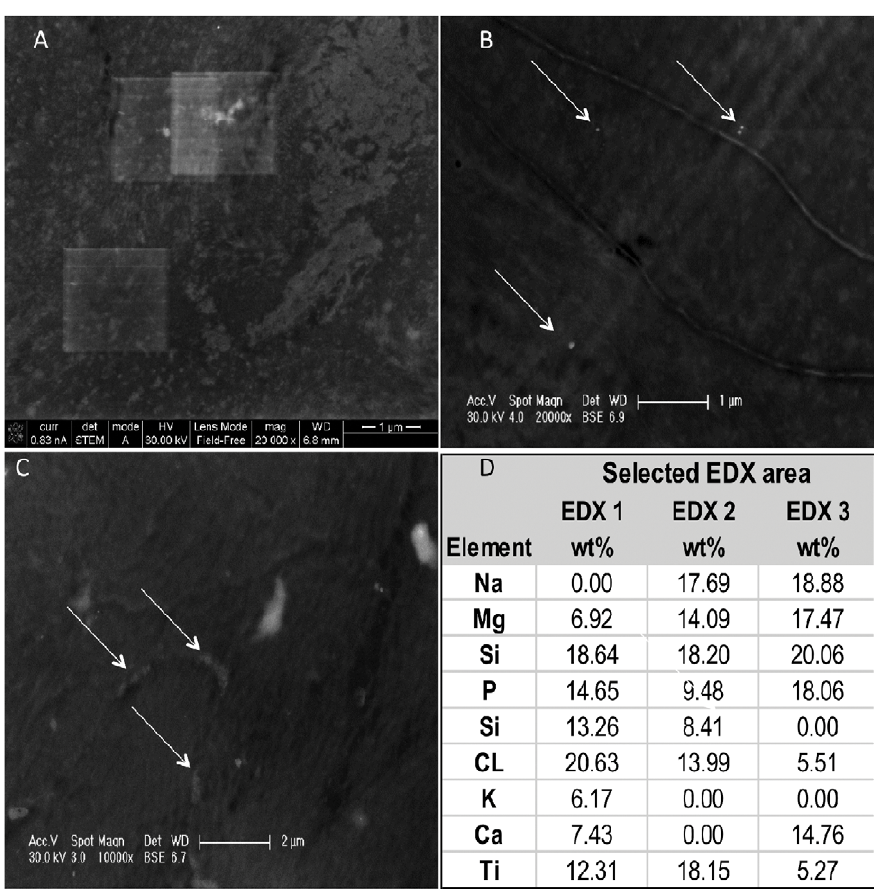
Figure 4. STEM micrographs of TiO 2 penetration into dermal tissue (Panels A–C). EDX analysis confirms the bright spots imaged in the skin tissue contain titanium, with as much as 18.15 weight (wt) % (Panel D). Note the small TiO 2 aggregates and primary particles in the vasculature of the dermis (B). Additionally, tens to hundreds of NPs are found well within the dermis (C). All images are from sections 500 m m below the skin surface.